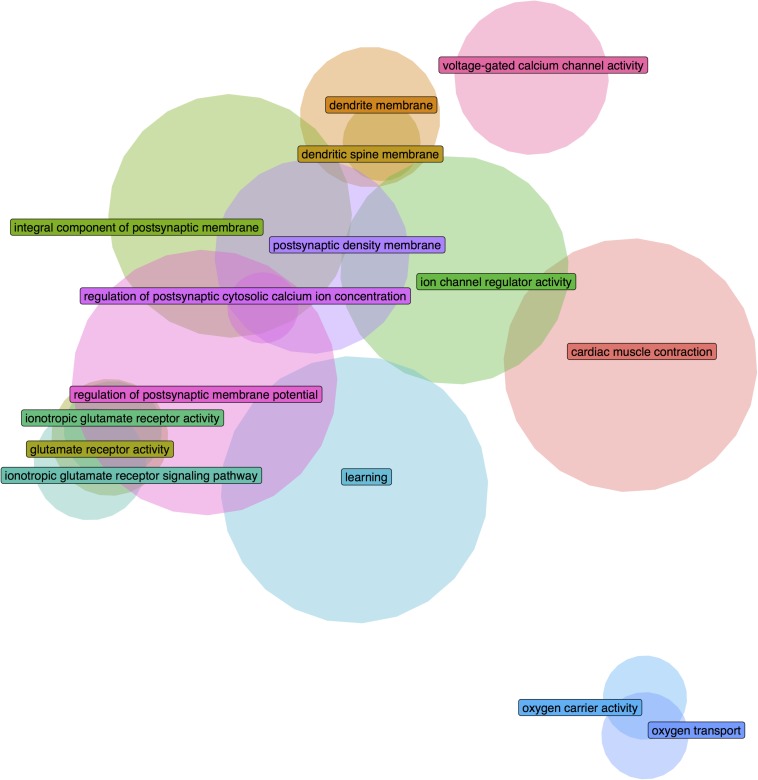
Euler diagram demonstrating gene overlaps between the significantly enriched GO groups in the adult long insular gyri that are also validated in the fetal granular insular cortex.